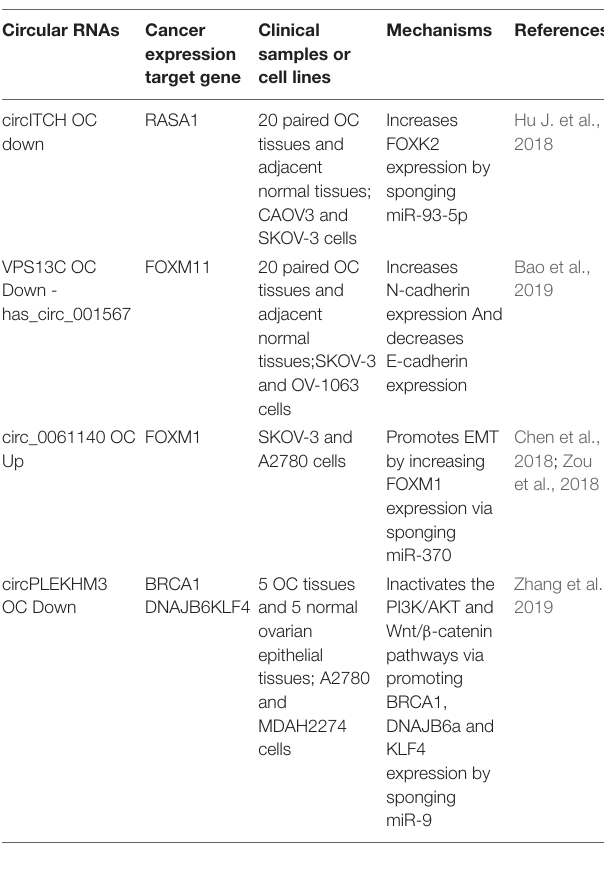
TABLE 2 | The expression and mechanisms of circRNAs in ovarian